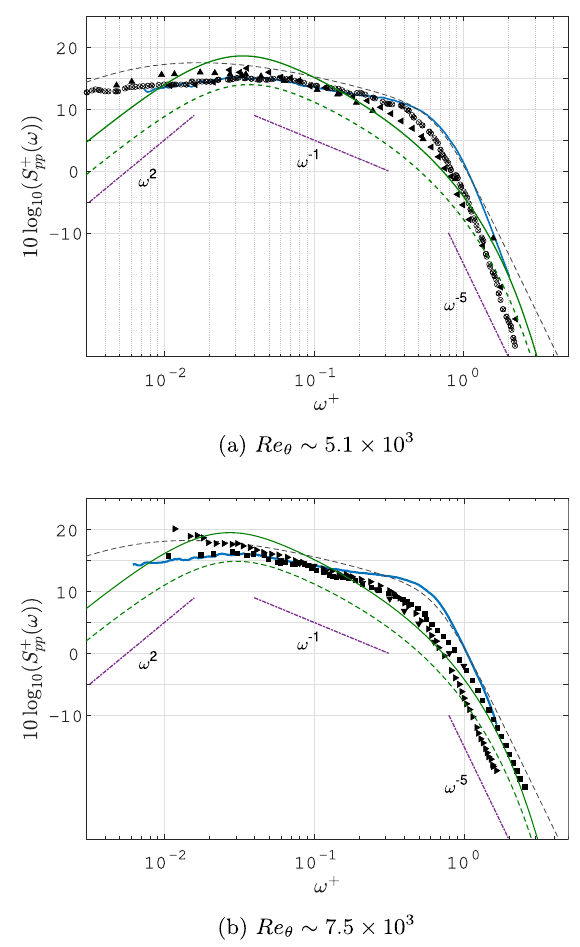
Figure 6. Comparison of modelled spectra with previous studies at similar Re h . Data from: Prigent, Salze, and ⊕ ⊗ Bailly [29], Schewe [35], and } Farabee and Casarella [36], ◄ and & Gravante et al. [37], N Olivero-Bally et al. [38], ► Goody and Simpson [39], ▼ Bull and Thomas [40], Blake [41] and d Goody and Simpson [39]. Models, matching condi- tions from Prigent, Salze, and Bailly [29]: – – – Goody model, extended Lysak, extended tno. power laws added for reference.